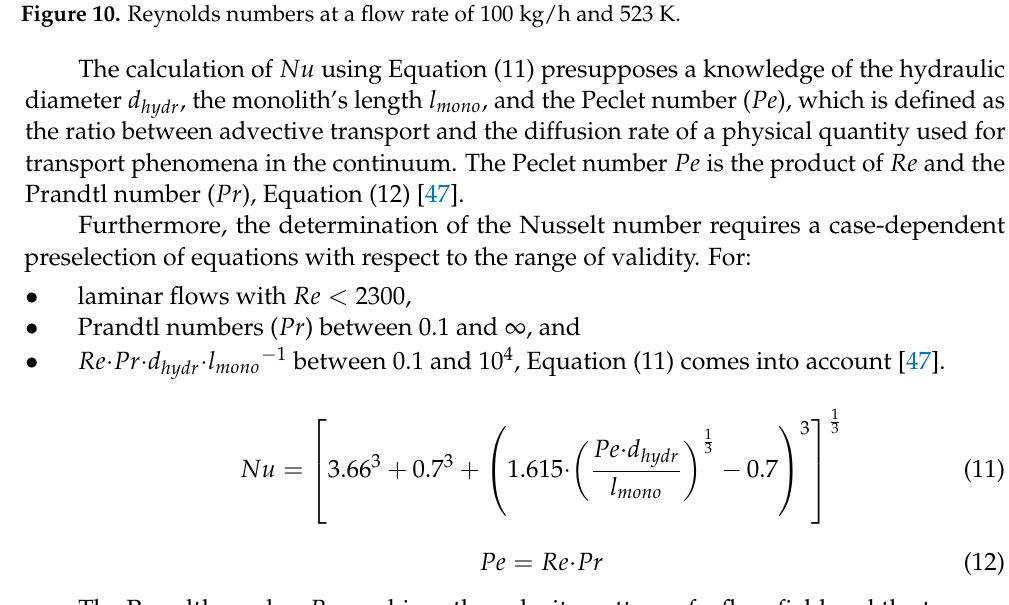
Figure 10. Reynolds numbers at a flow rate of 100 kg/h and 523 K.